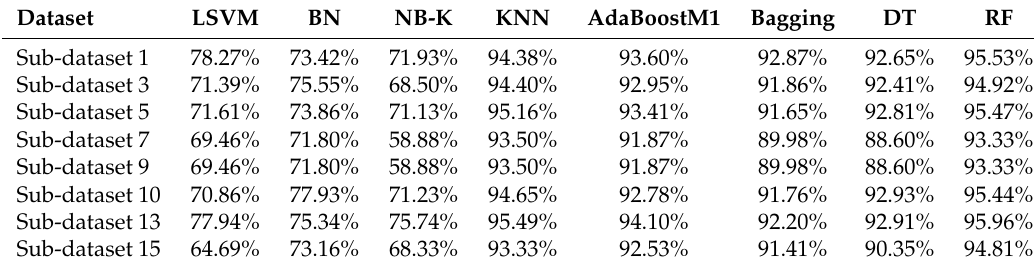
Table 3. Accuracy results under binary classification.